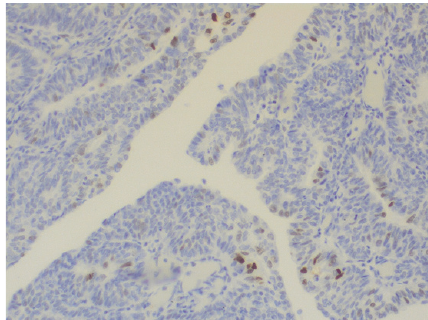
Figure 4: H&E stain: superficial invasion of the uterine cervix by the endometrial